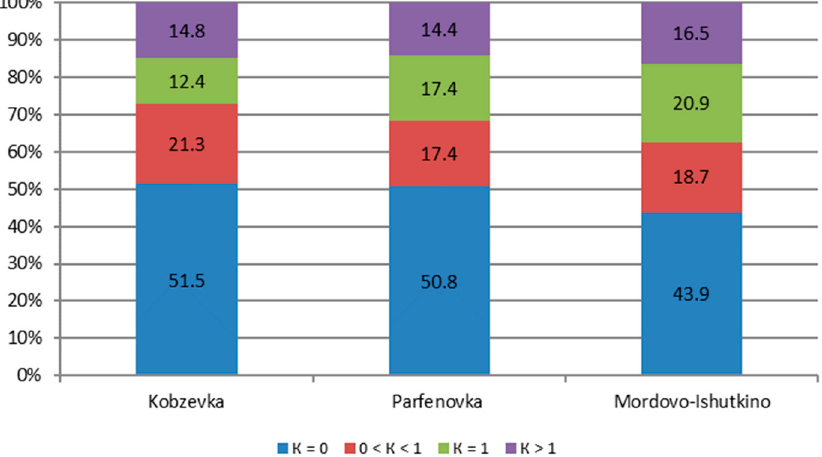
Figure 6. Comparison of private household plots in relation to the number of employed and unem- ployed members in 2014–2018.